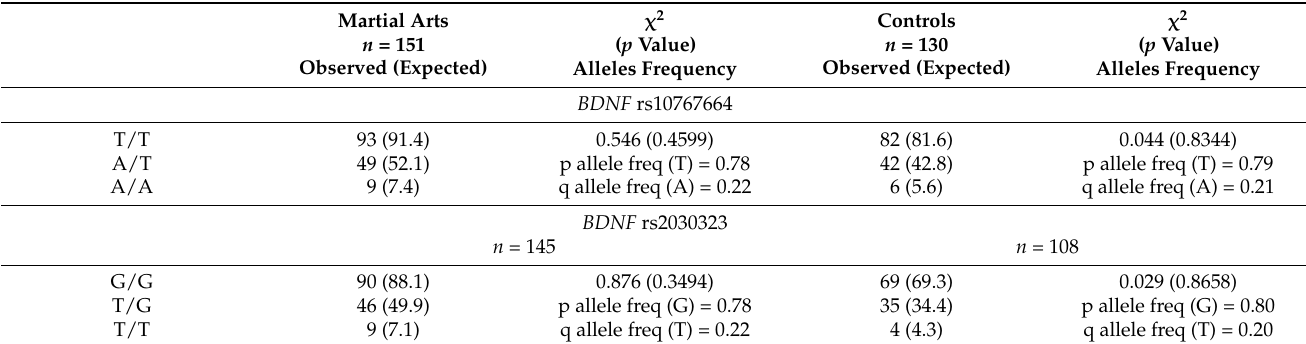
Table 1. Hardy-Weinberg equilibrium of BDNF rs10767664 and BDNF rs2030323 in the groups of martial arts subjects and